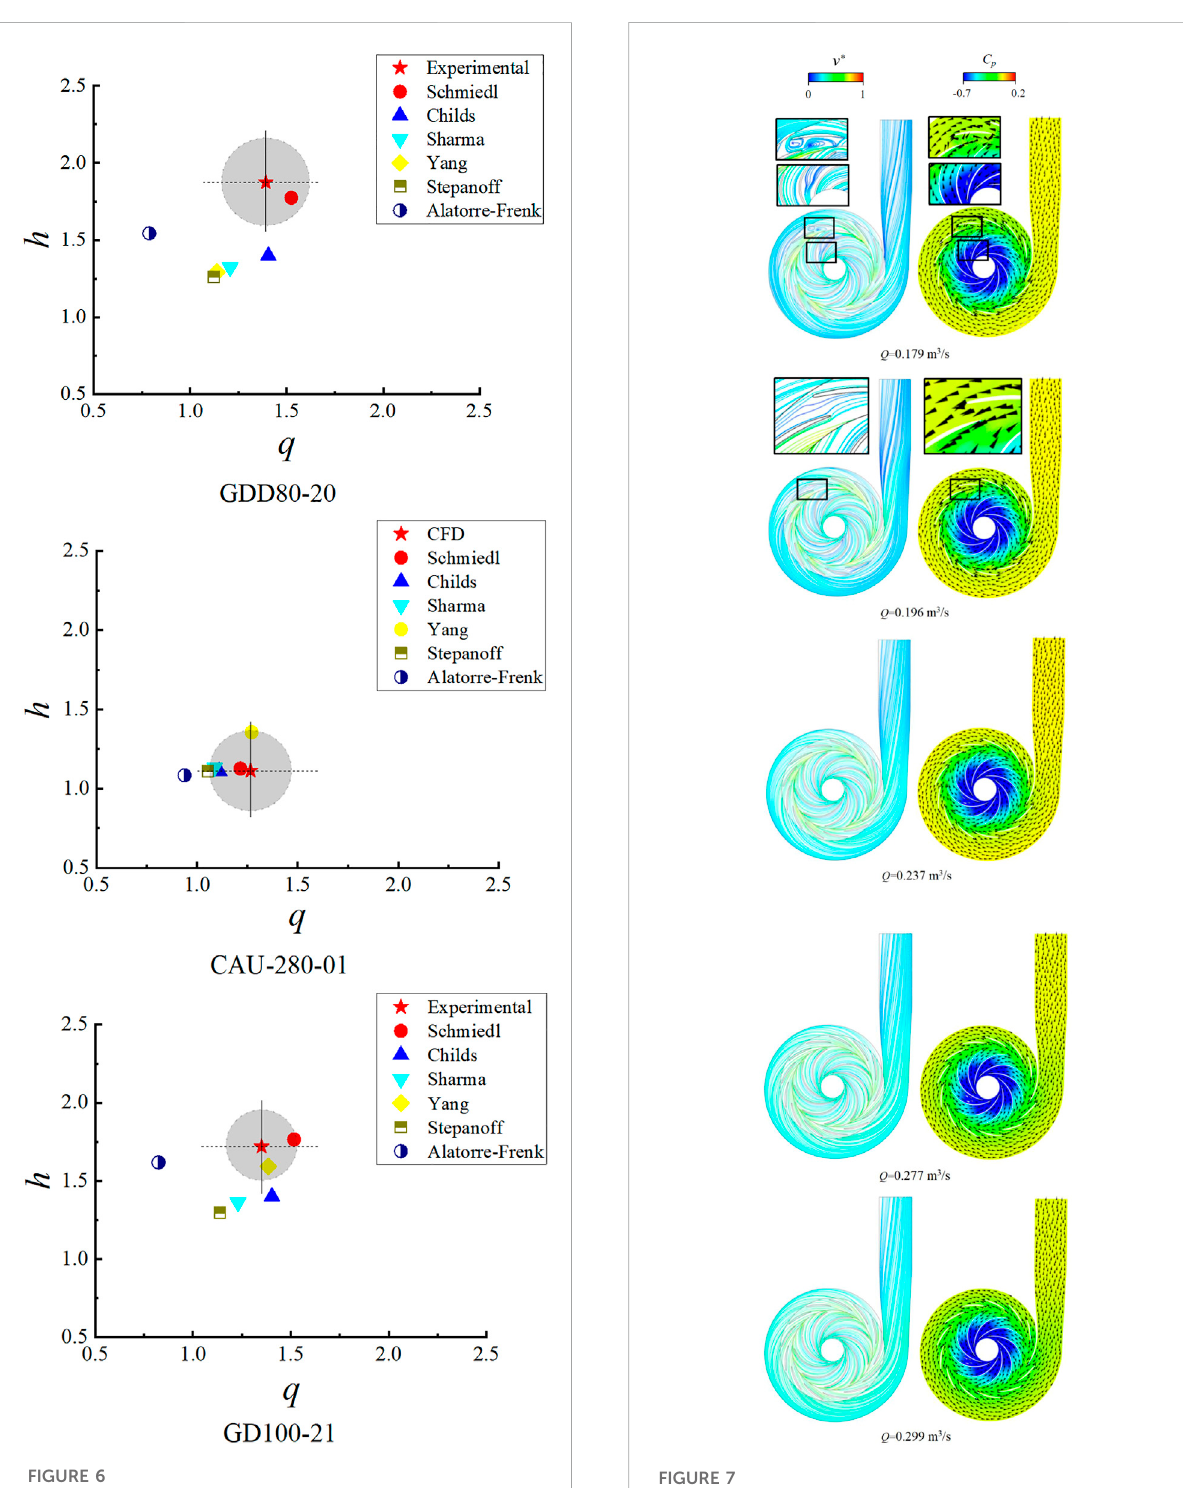
FIGURE 6 Error analysis of performance prediction formulas.